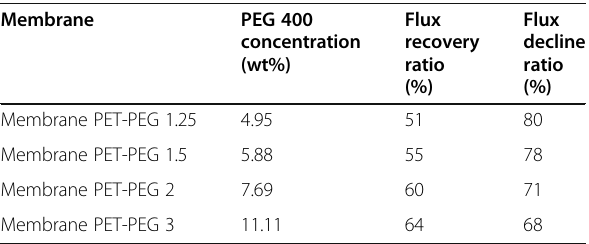
concentration (wt%)